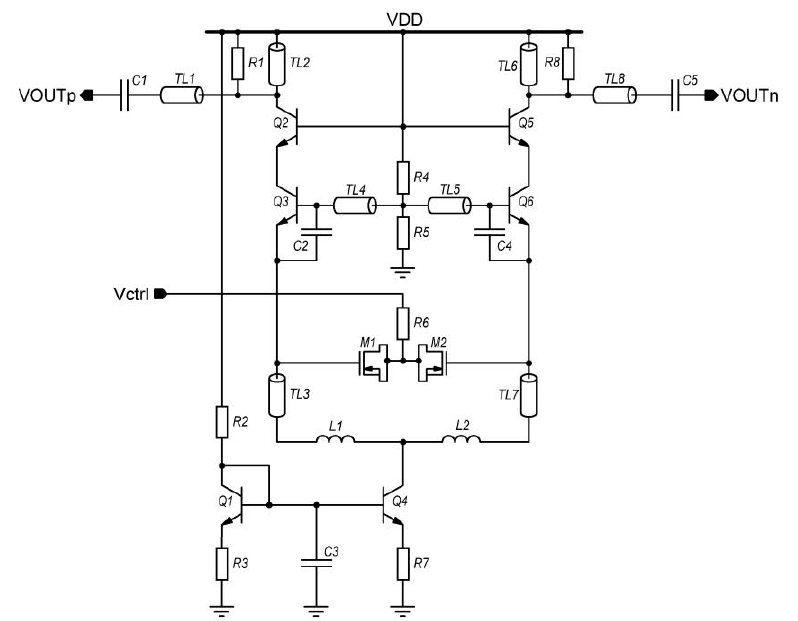
Fig. 2. Schematic of the W-band fundamental Colpitts